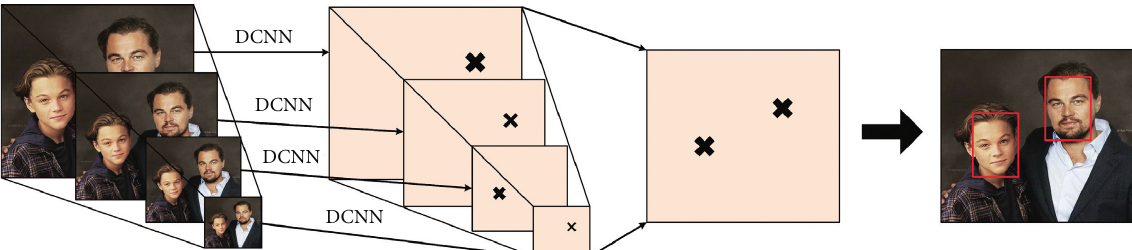
Figure 4: Flow chart of face detection in face image.